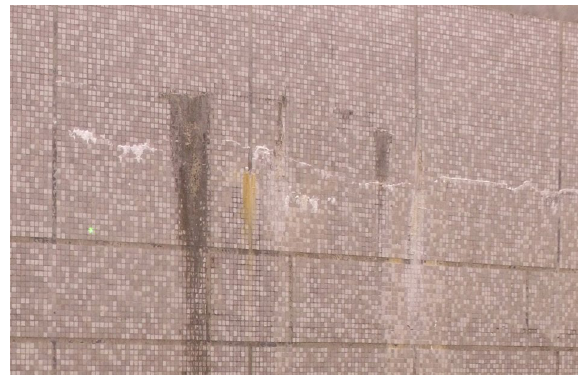
Figure 6. The close-range horizontal photography by UAV’s camera